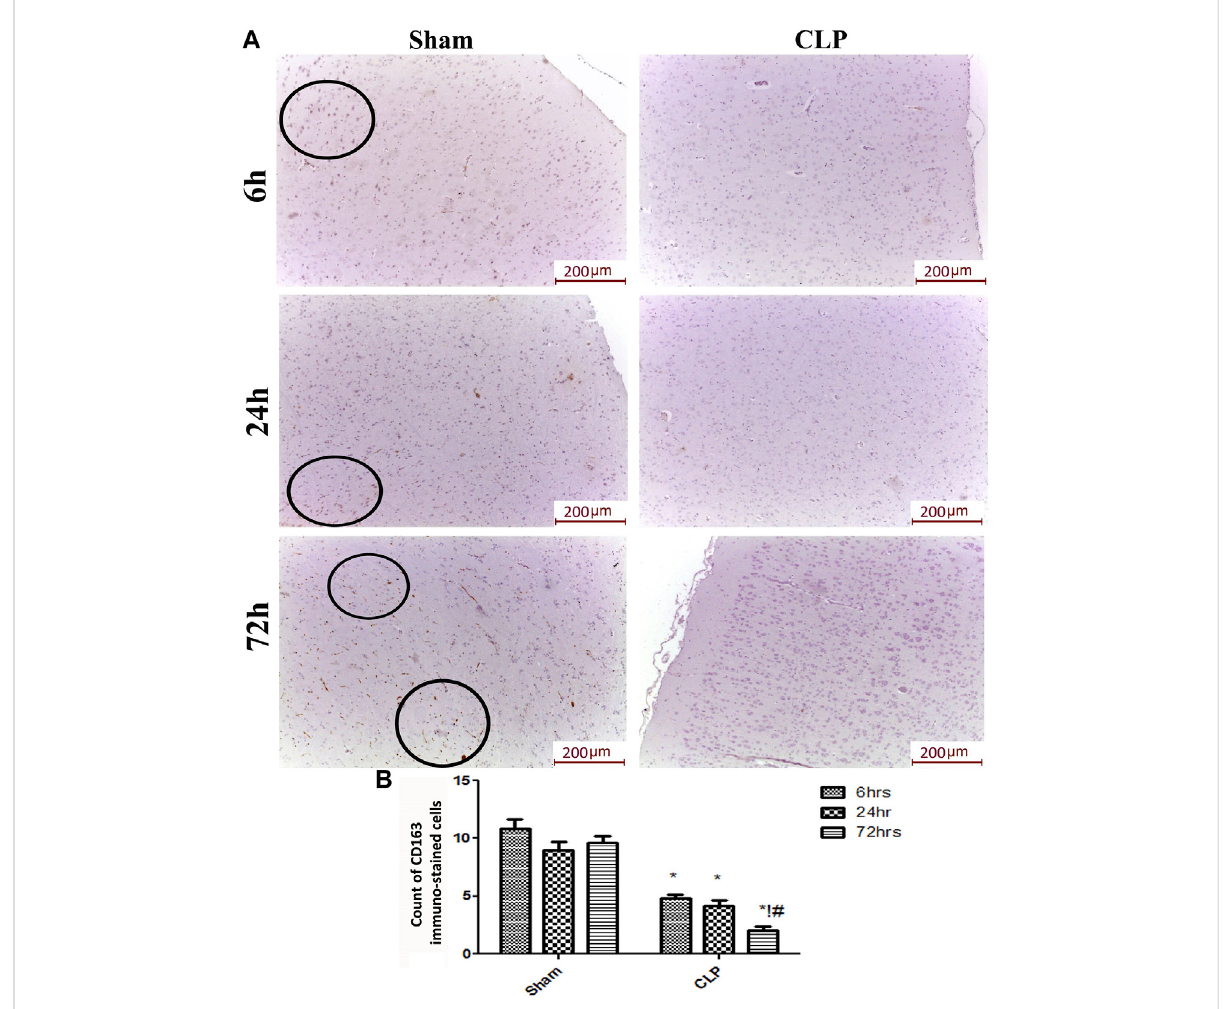
FIGURE 7 Sepsis mitigated the in fi ltration of CD 163 macrophages in brain tissues. (A) Representative images of immunohistochemical staining for CD163intheshamandcecalpunctureandligation(CLP)groupsatdifferenttimepoints. (B) Countof163immunohistochemicallystainedcells.Data arepresentedasthemean±S.E.M.( n =6).*:Statisticallysigni fi cantvs.theSham;!:signi fi cantvs.6 hCLP,#:signi fi cantvs.24 hCLP,asassessedusing ANOVA with the Bonferroni post-hoc